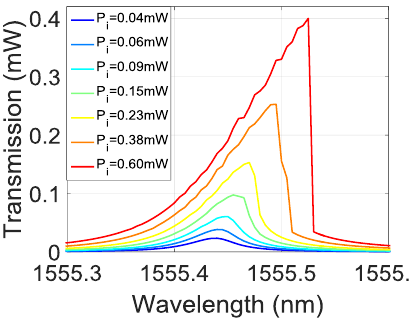
Figure 4. Simulated transmission spectra of a π -phase shifted grating as a function of injection